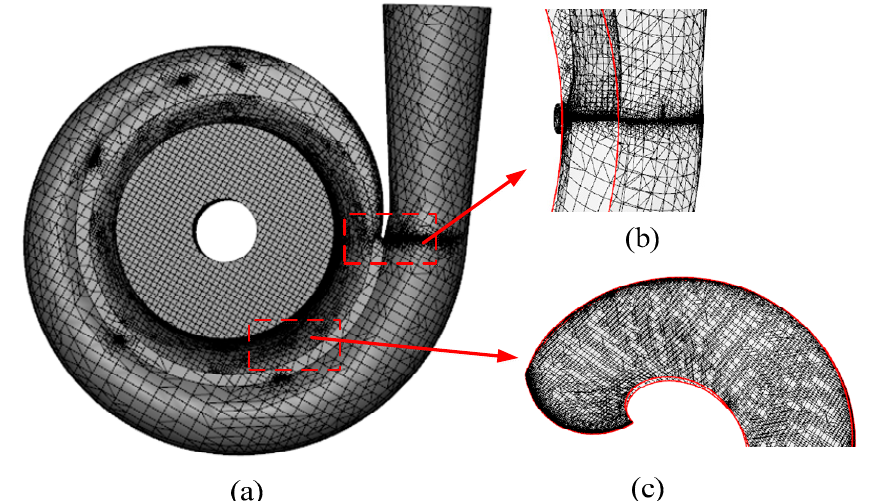
Figure 5. Details of the generated mesh grids: ( a ) the mesh model of the pump; ( b ) the refined mesh model in the volute tongue; ( c ) the refined mesh model in an impeller inlet.